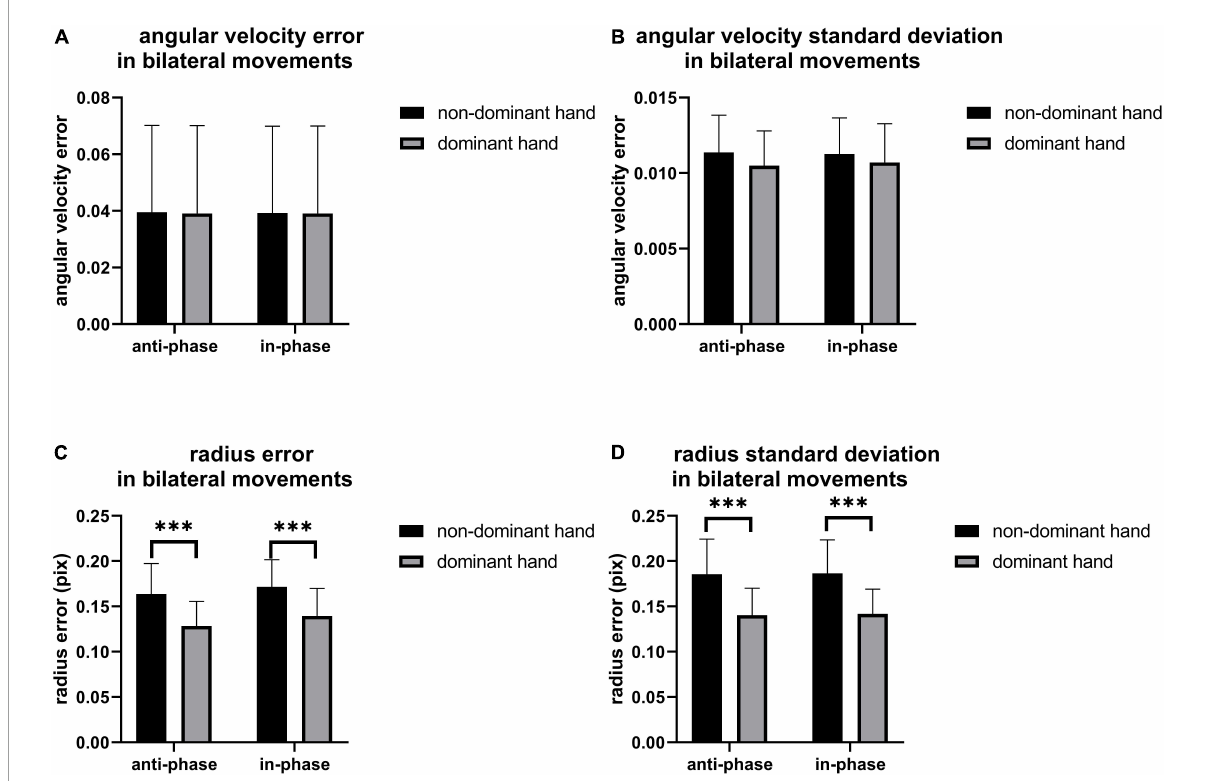
other hand, Figure 7 shows that IP movements were more dependent on the dominant left cortical control, with more activation on the dominant hemisphere than the